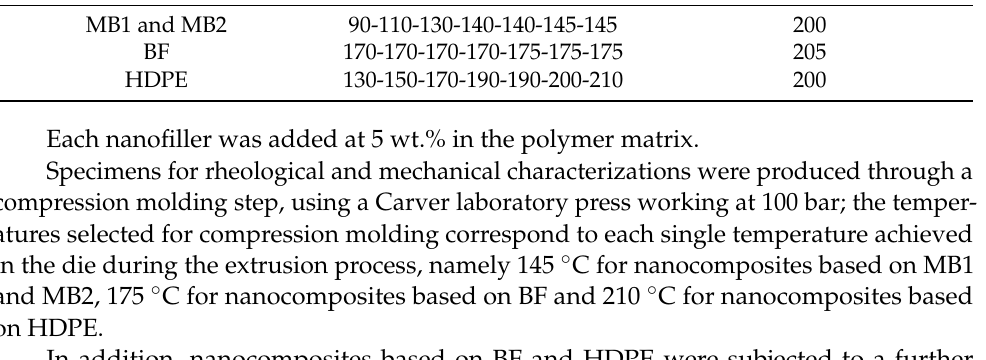
Table 1. Processing conditions in the twin screw extruder for the formulation of all the nanocomposites. Polymer